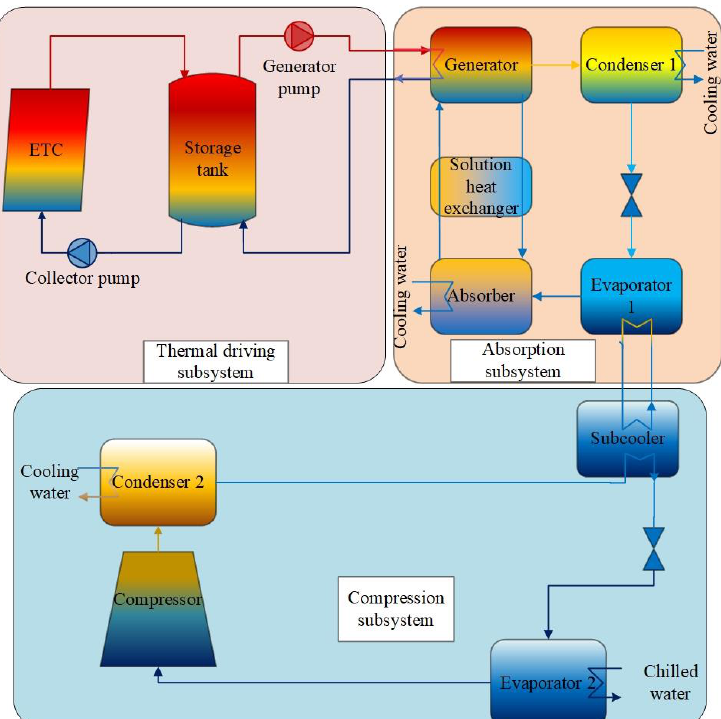
Figure 1. Schematic of solar absorption-subcooled compression hybrid cooling system (SASCHCS).